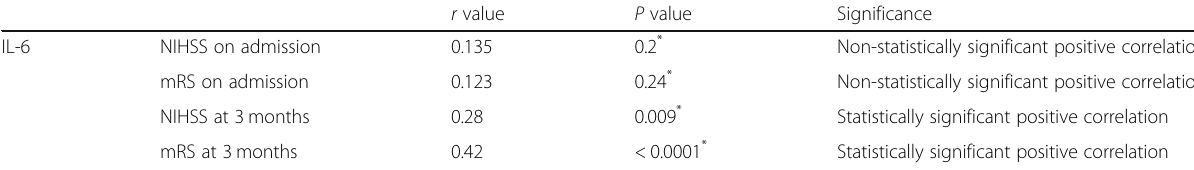
Table 3 Correlation between IL-6 levels and both NIHSS and mRS levels on admission and after 3 months